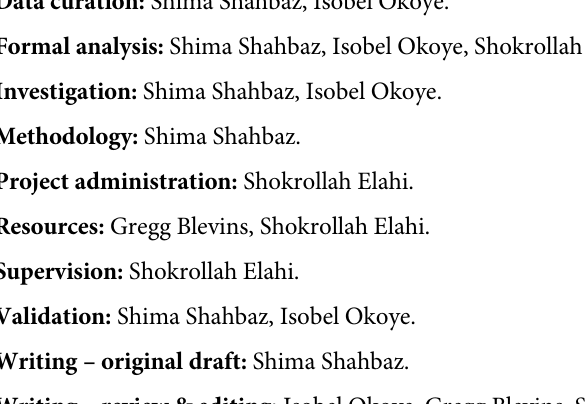
(20 ng/ml). ( H-K ) Fold regulation of miRNA30b-30e in isolated CD8+ T cells after their treat- ment with their corresponding miRNA-inhibitors quantified by qPCR. Data are obtained from multiple independent experiments. Statistical analysis determined by the Mann-Whitney U-test (A-E, H-K) and Kruskal–Wallis test (F and G). (L ) The representative histogram plot showing the purity of total CD8 + , ( M ) CD73 - , CD73 + , and (N ) effector CD8 + T cells. (TIFF) S1 Table. Showing patients clinical information (CD4 count and viral load) and disease status (e.g. Long-term non-progressors (LTNPs), on antiretroviral therapy (ART) and those who have never been on ART (ART-na ï ve) or newly diagnosed. Male (M) and female